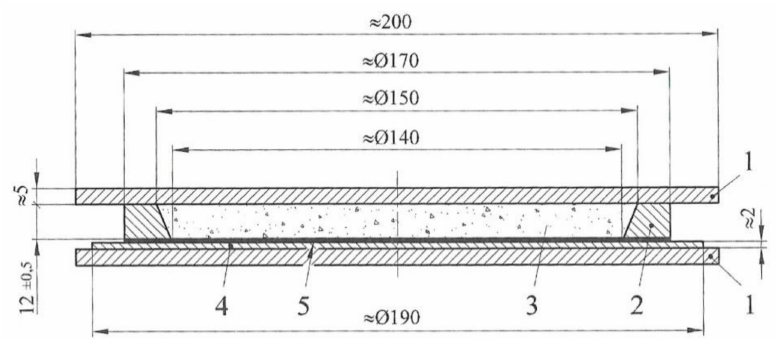
Figure 4. Typical test arrangement for determining the water retention of fresh